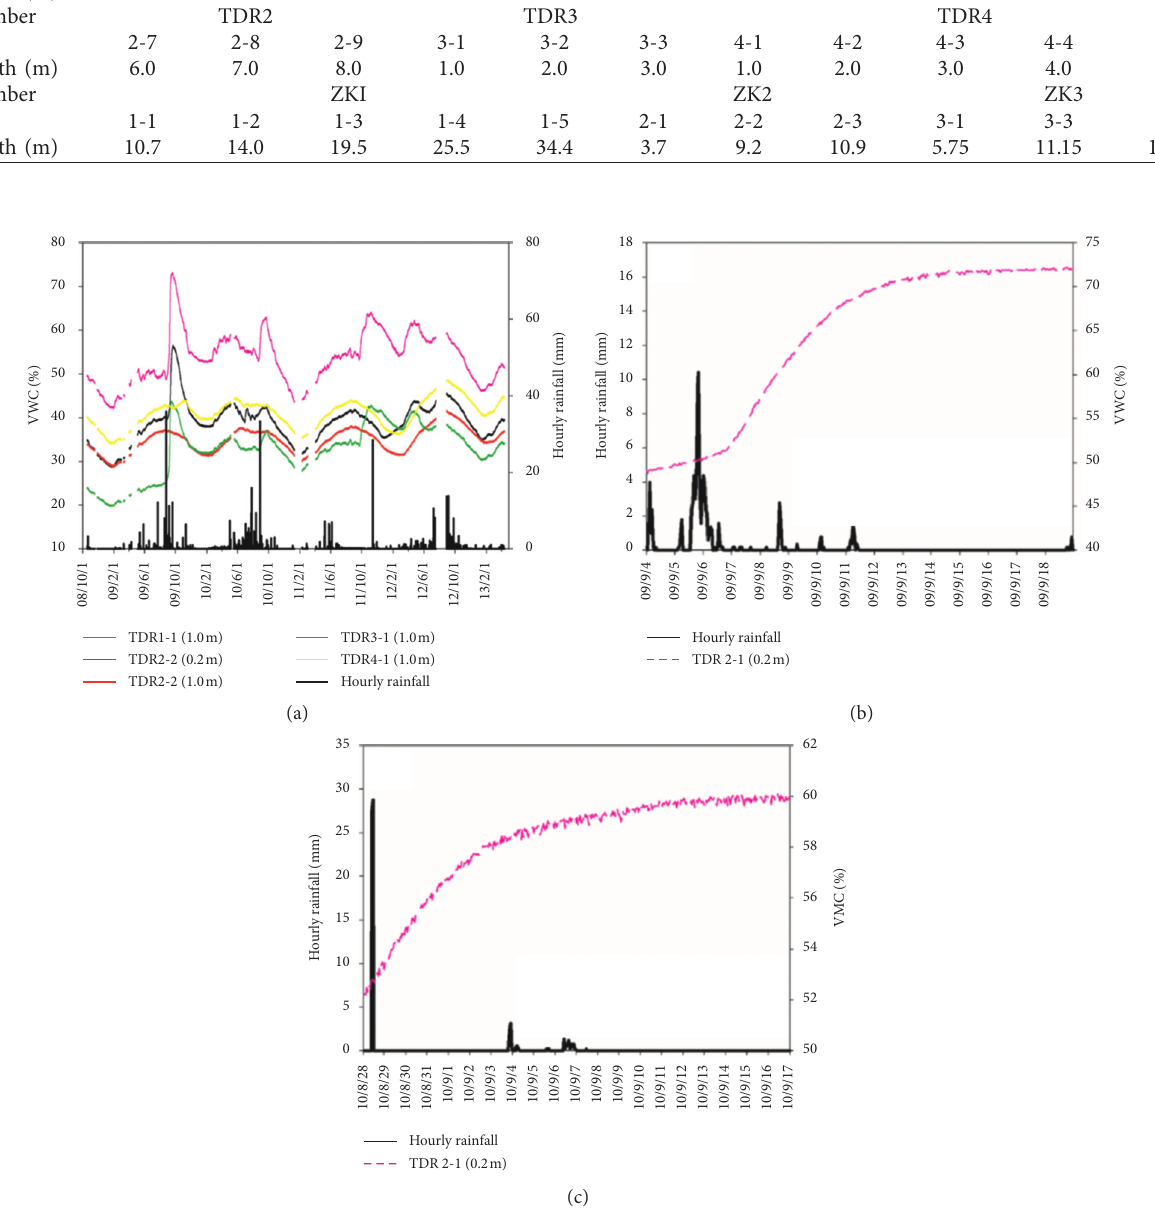
Figure 3: Relationship between VWC and rainfall per hour: (a) changing of VWC on the surface soil; ((b, c)) specific